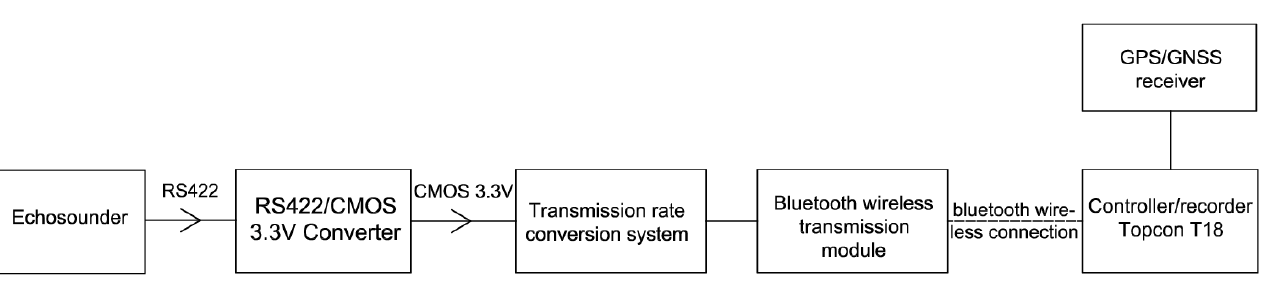
Figure 5. Scheme of the surveying procedure and data